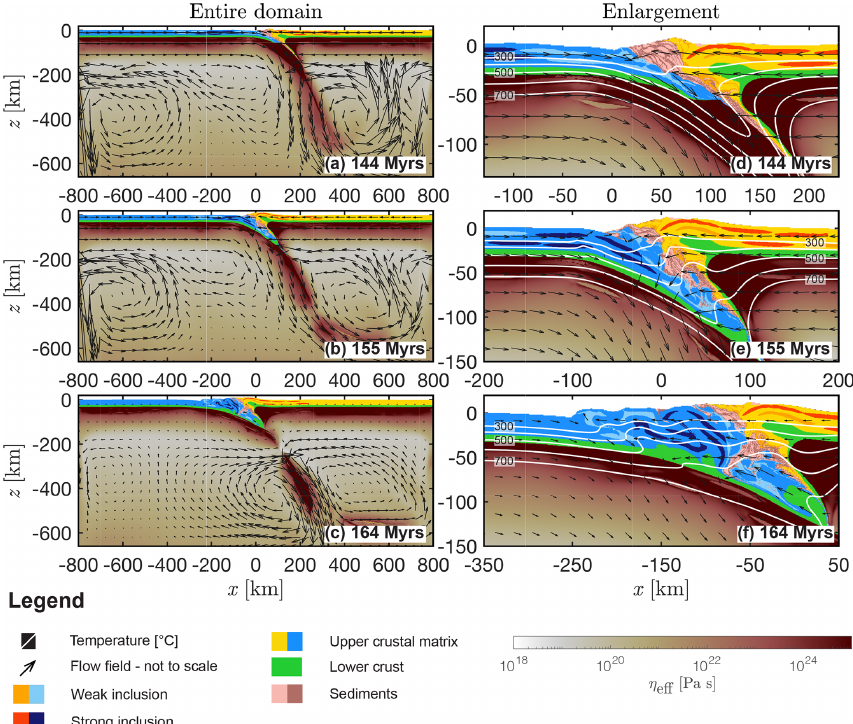
Figure 5. Evolution of the reference run REF after closure of the marine basin and continent–continent collision. White to dark red indicates the effective viscosity of the mantle material calculated by the algorithm, yellow to orange indicates the crustal matrix and the weak and strong inclusions of the overriding plate, light to dark blue indicates the corresponding crustal units of the subducting plate. The material parameters used for the upper crustal phases of the overriding and the subducting plates are identical. Green indicates the lower crust of both plates and salmon and brown indicates the sedimentary units. White lines are different isotherms and the arrows indicate the velocity